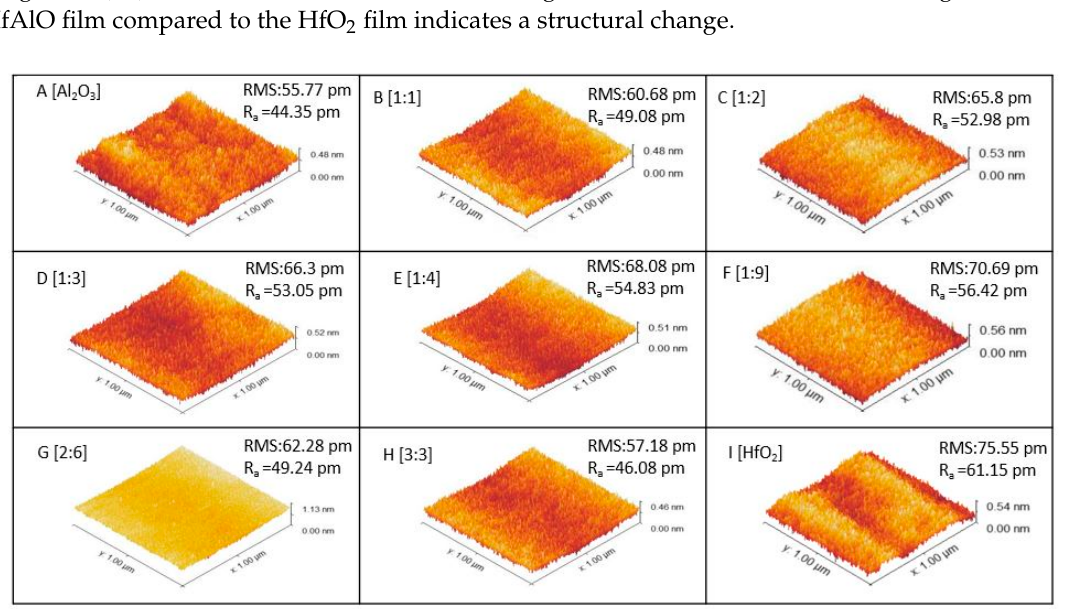
Figure 5. Trap characterization of HfAlO films with different Hf concentrations assumed by atomic-layer-deposition (ALD) cycle ratio: ( a ) interface trap density (D it ) and ( b ) border tap density (N bt ). Inset: frequency dispersion of accumulation capacitance at an applied bias of 2 V. Figure 5 shows the interface trap density and border trap characterization along with an illustration of frequency dispersion. The conductance method was used to calculate the interface